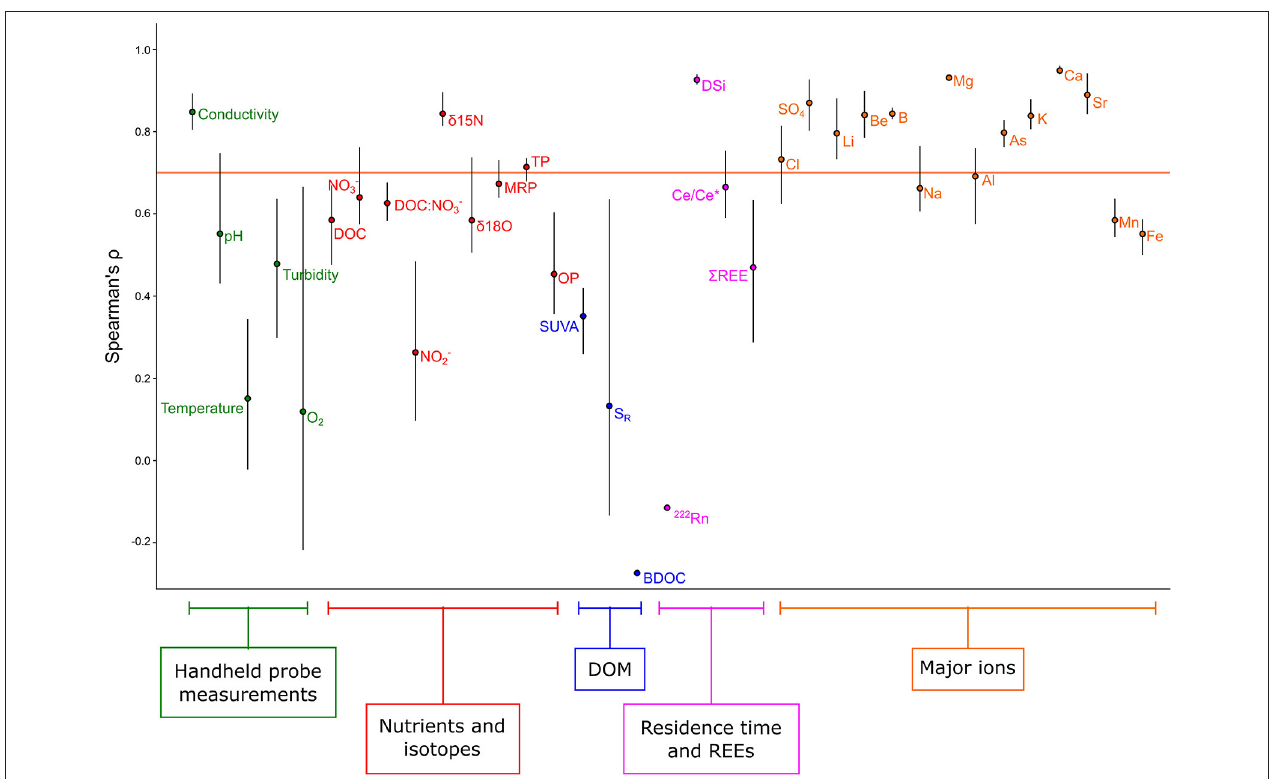
FIGURE 5 | Spatial stability of biogeochemical tracers and chemical concentrations across all 49 watersheds. Parameters are grouped thematically by color. Solutes with a Spearman’s ρ above the horizontal line maintain more than half the spatial pattern for that parameter in pairwise comparisons among the three sampling dates.